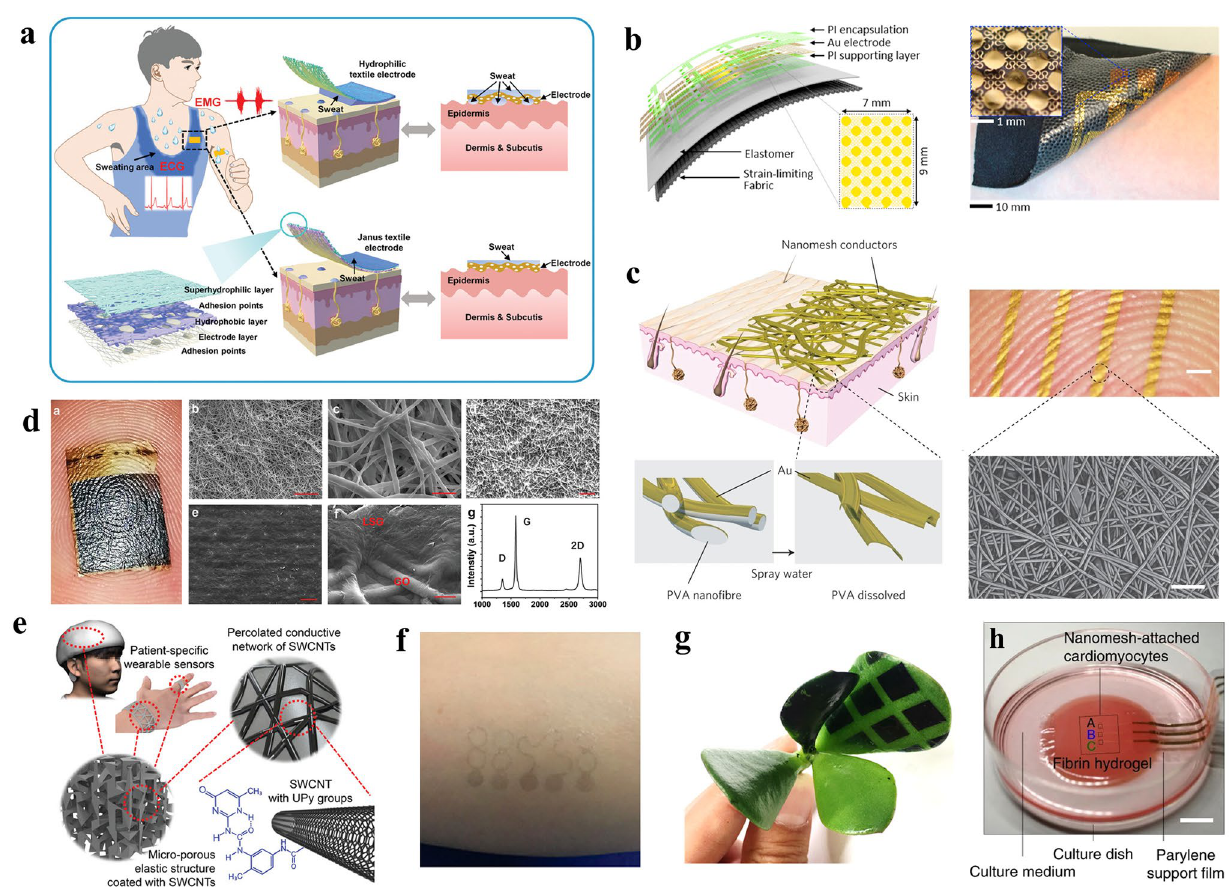
Fig. 2 a The all‑nanofiber‑based e‑skin electrode with directional sweat transport properties. Reproduced with permission from Ref. [43]. Cop‑ yright 2022 Wiley. b SEM images of textile electrodes made from different conductive elastomeric fibers. Reproduced with permission